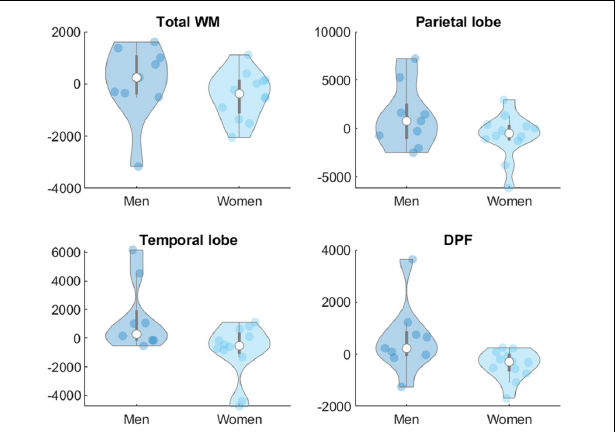
FIGURE 2 | Sex difference in changes in brain volumes (Level 2) in mm 3 for group AE. WM, white matter; DPF, dorsolateral prefrontal cortex.